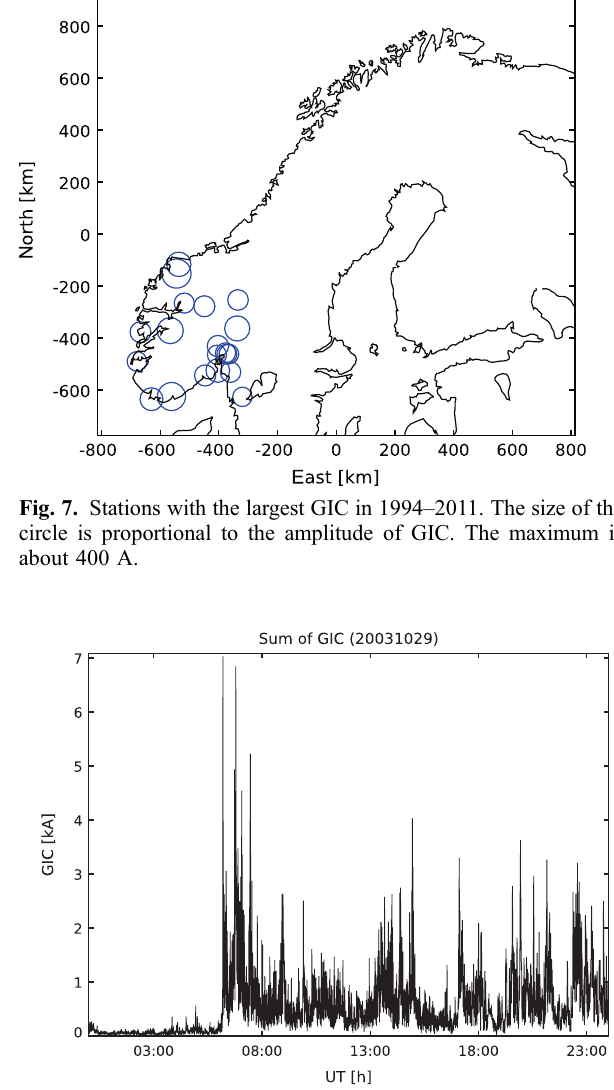
Fig. 8. Sum of GIC in the nodes of the Statnett 2012 grid assuming the event on 29 October